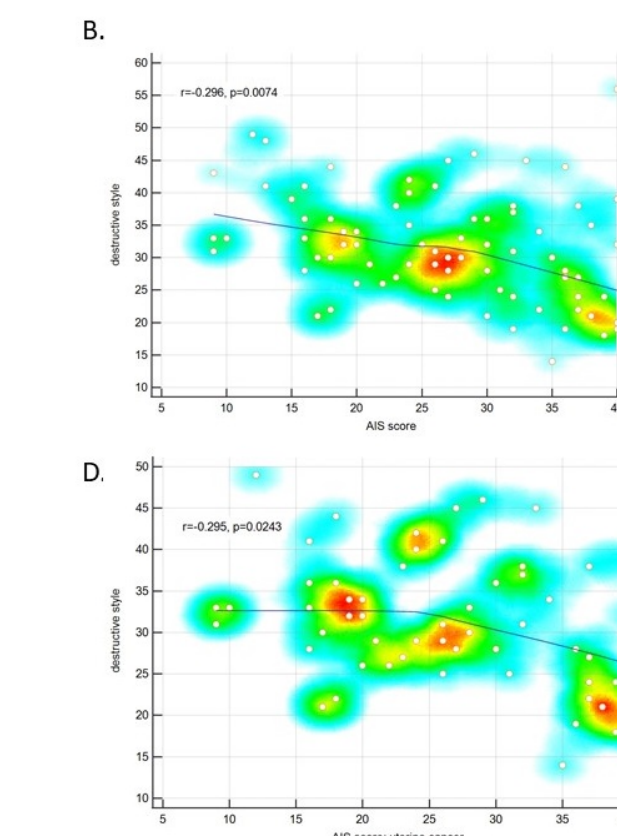
constructive mental adaptation style ( A ), the destructive mental adaptation style ( B ), the